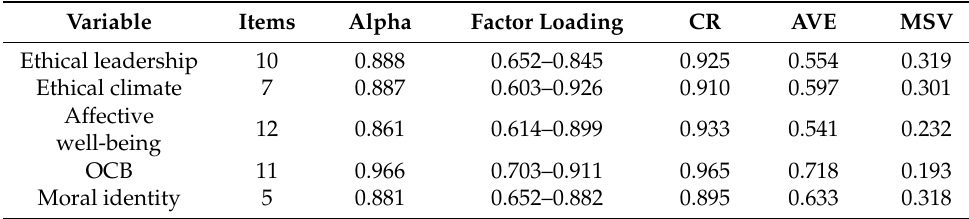
Table 1. Reliability and validity of